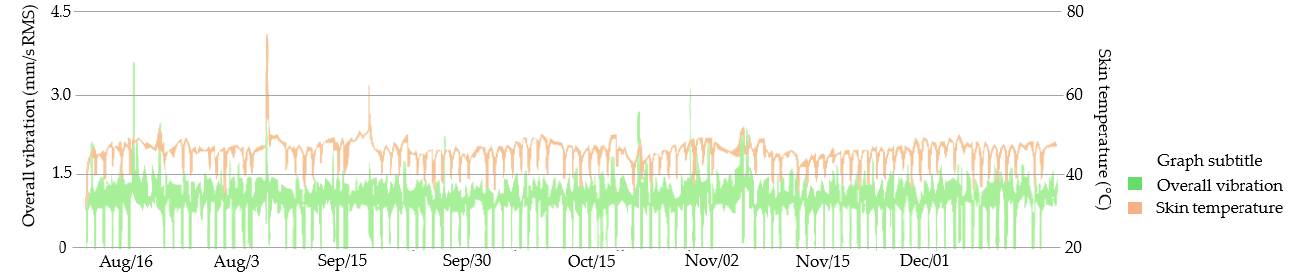
Figure 12. Motor 1 previous monitoring by the smart sensor.